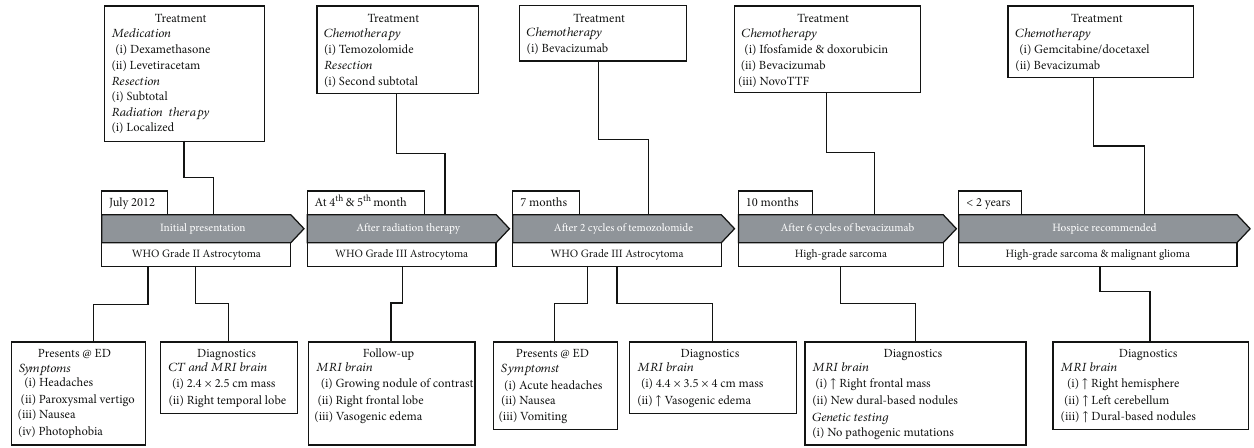
Figure 1: Timeline of the case